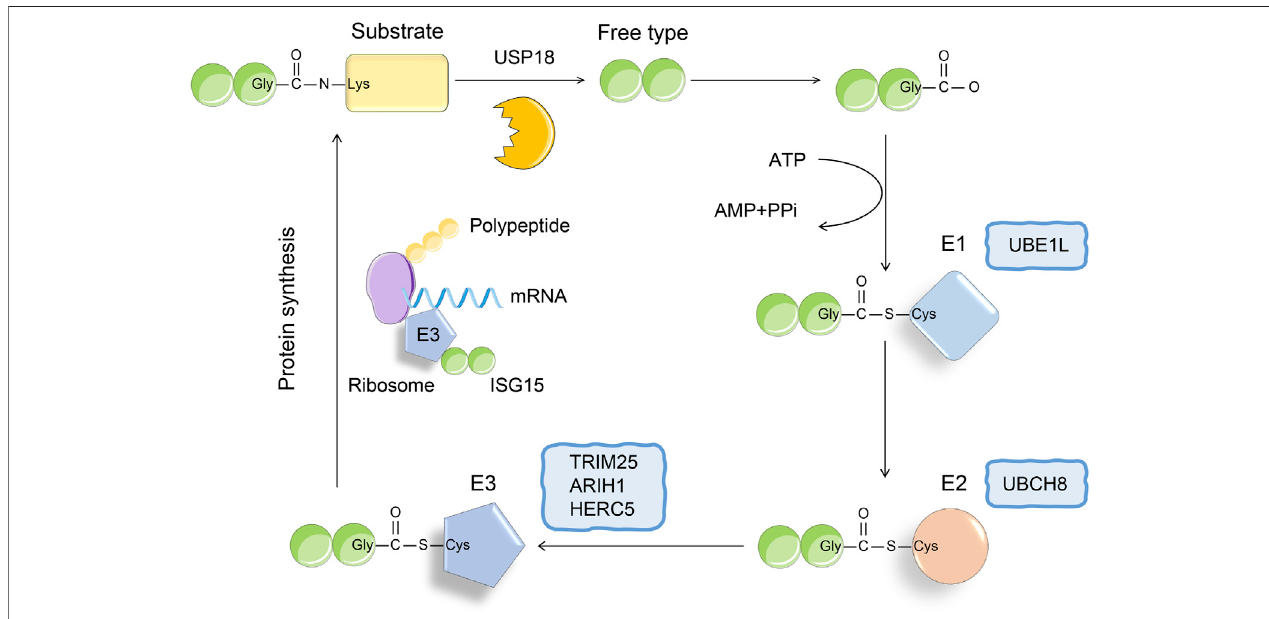
FIGURE 1 | The conjugation of ISG15. The binding process of ISG15 and substrate is similar to the three-step enzyme cascade reaction of ubiquitination. The formation of thioester bond between E1 activating enzyme (UBE1L) and ISG15 depends on ATP, thereby activating ISG15. Next, SIG15 is transferred to the cysteine activesiteofE2ligase(UBCH8).Finally,E3ligasebindstopolysomes,therebypromotingthebindingofISG15tothenascenttargetprotein.TheprocessofISGylationis reversible, and USP18 as a deubiquitinating enzyme can speci fi cally remove ISG15 from the binding protein.